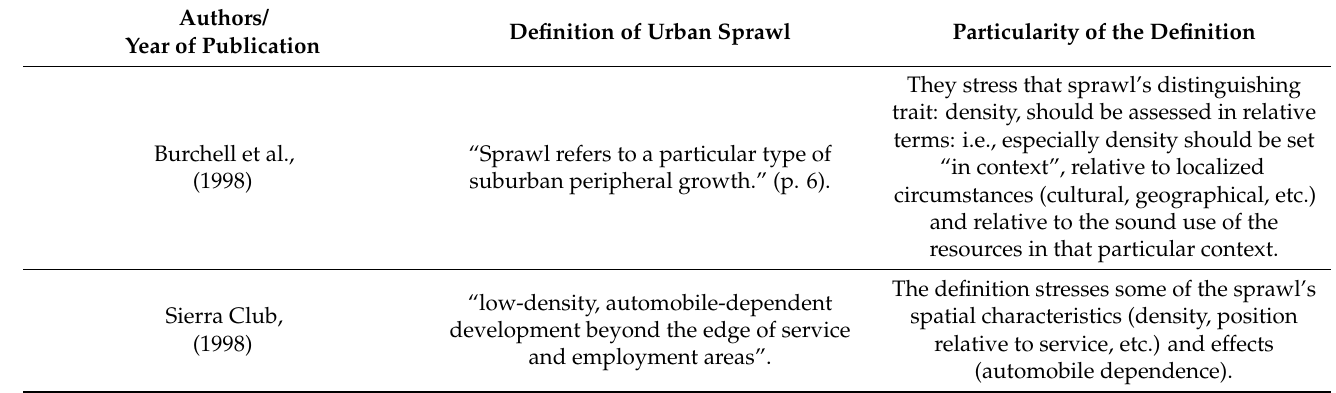
Table 2. The definitions of sprawl: summary of findings [36] (p.